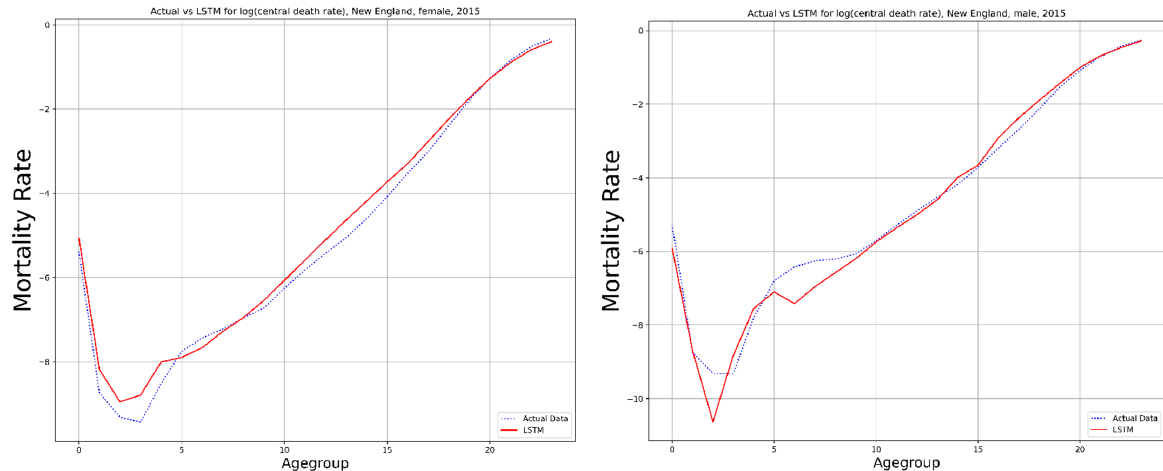
Figure 10. The predictions of the log-mortality rate for New England female ( left ) and male ( right ), 2015: LC (red) vs. actual (blue).